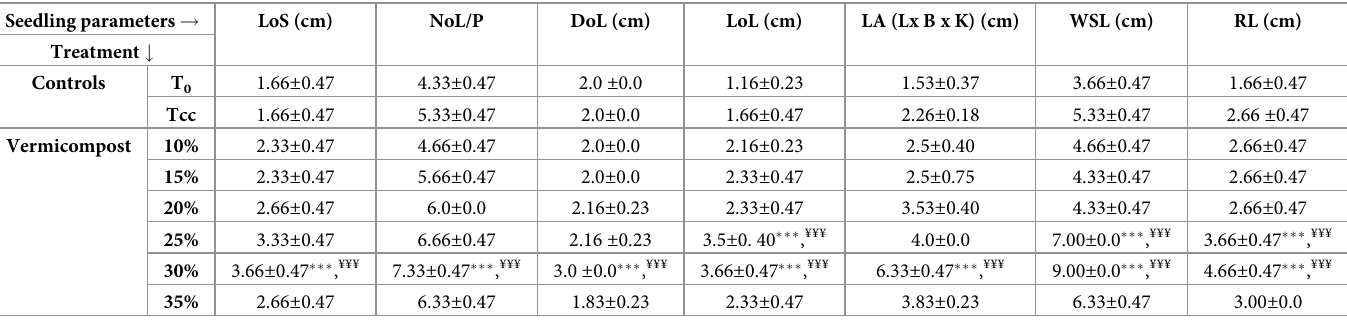
Table 3. Pansy seedling growth